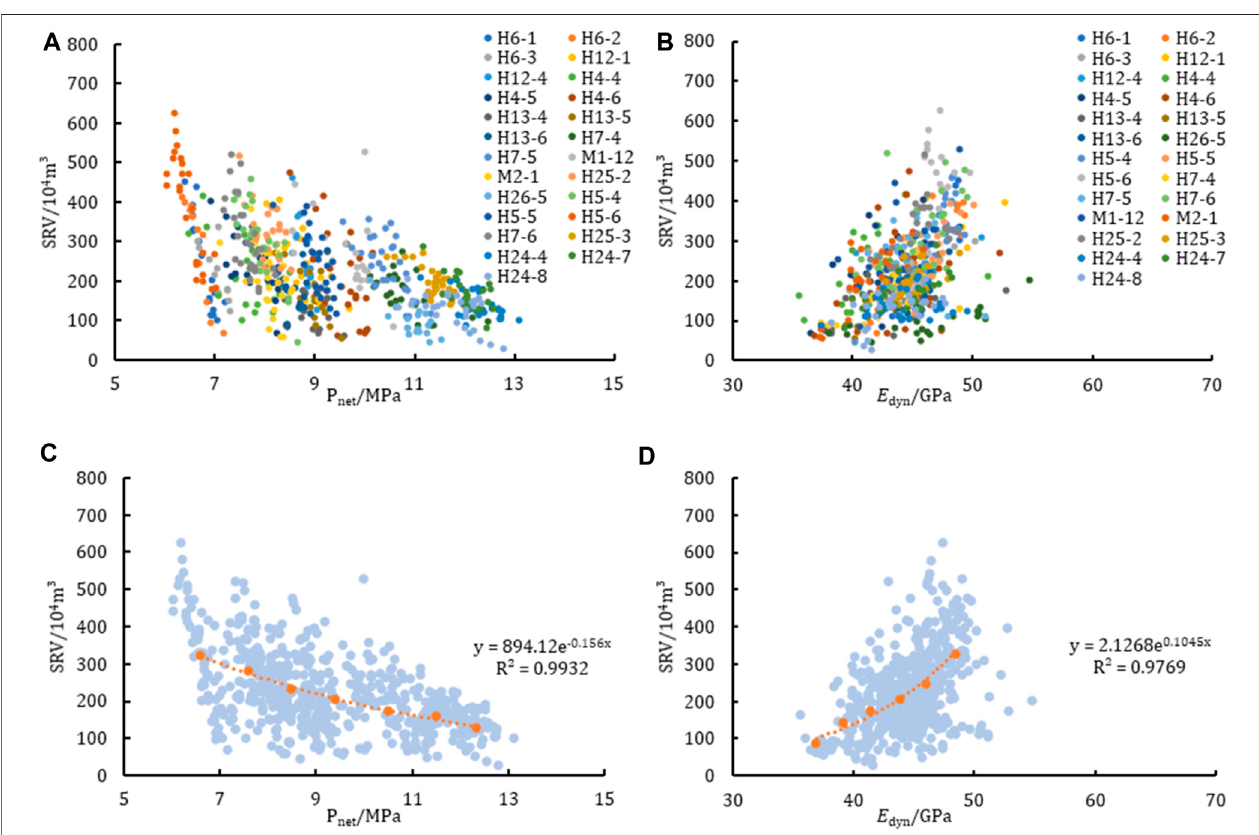
FIGURE 4 | Relationship among P net , E dyn of single segment and SRV of underground micro-seismic in Changning gas fi eld.